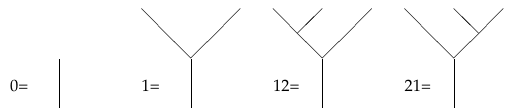
Figure 6. Admissible words and their corresponding binary trees.